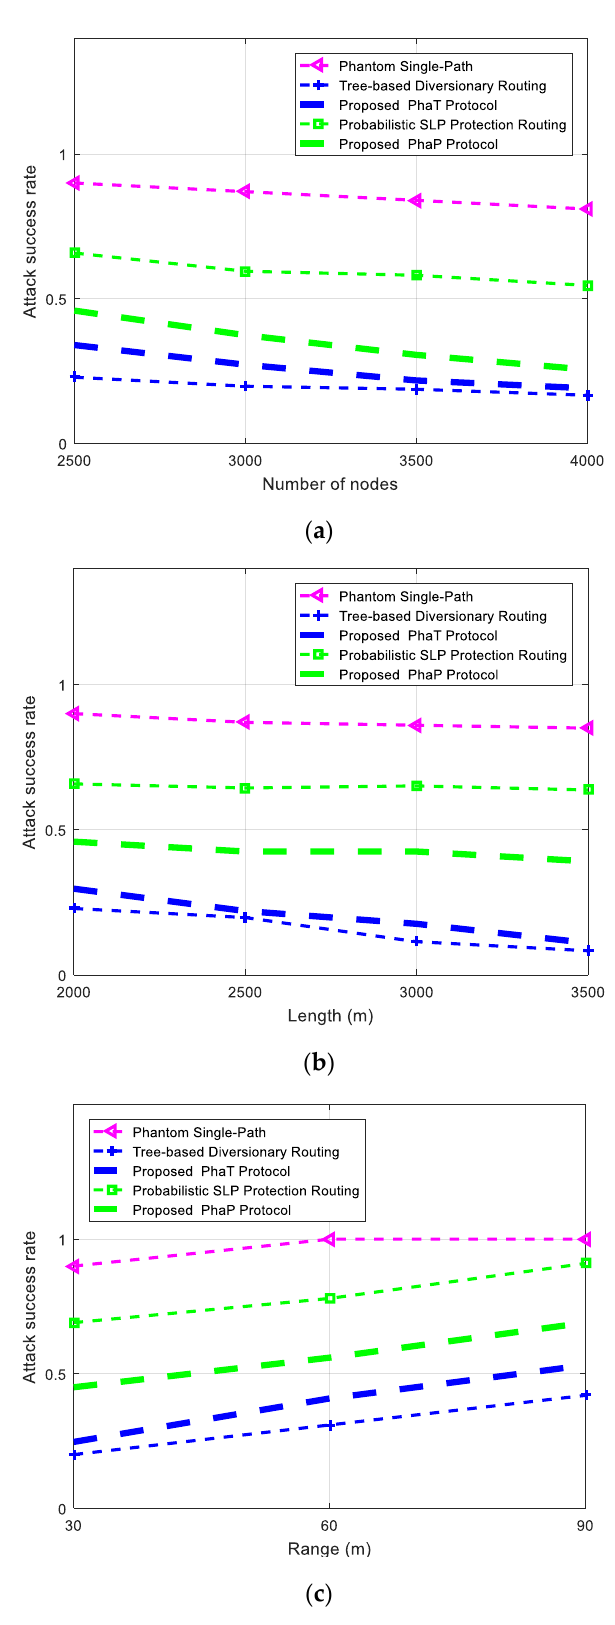
Figure 6. Attack success rate (ASR) against the protocols. ( a ) ASR under varied number of nodes in network. ( b ) ASR under varied network size. ( c ) ASR under varied adversary detection range.